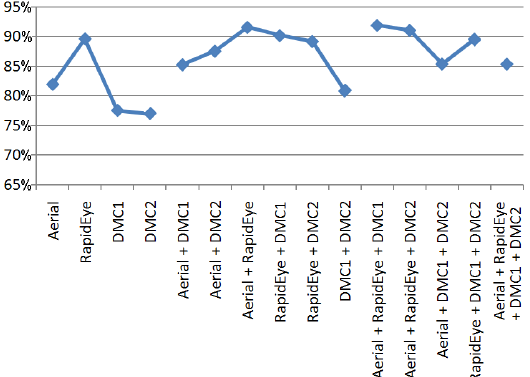
Figure 6: Global accuracies obtained for the classifications based on the entire possible combinations of input data.